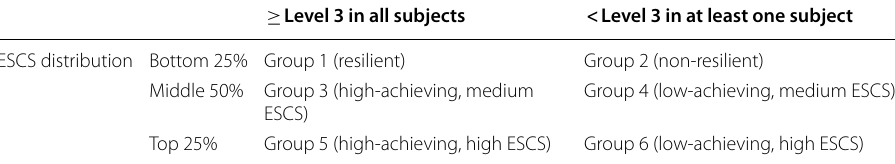
Table 4 Definition of School Groups